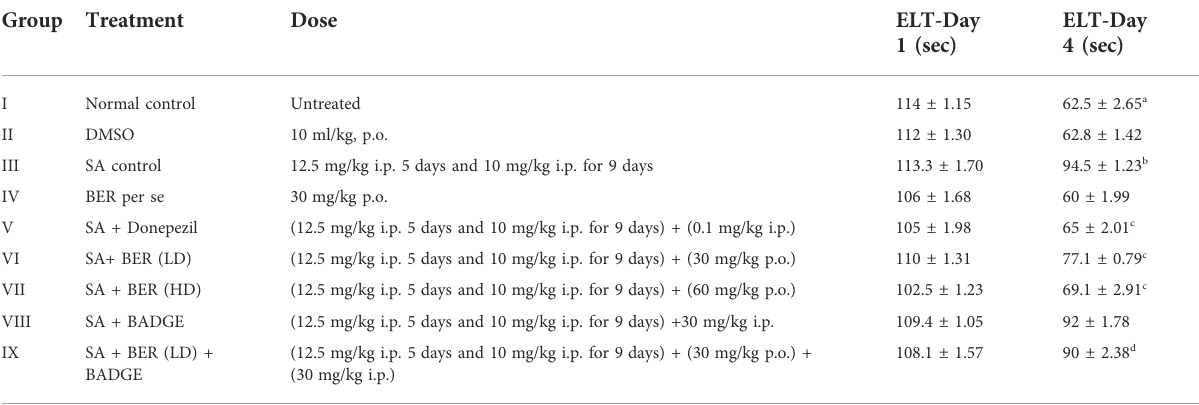
TABLE 3 “ Effect of pharmacological interventions on escape latency time (ELT) on day 1 and day 4 (time in seconds) using Morris water maze (MWM) test in sodium azide-treated rats. ” Performed in a way similar to our previously published work (Kaur and Sodhi, 2015). Group Treatment